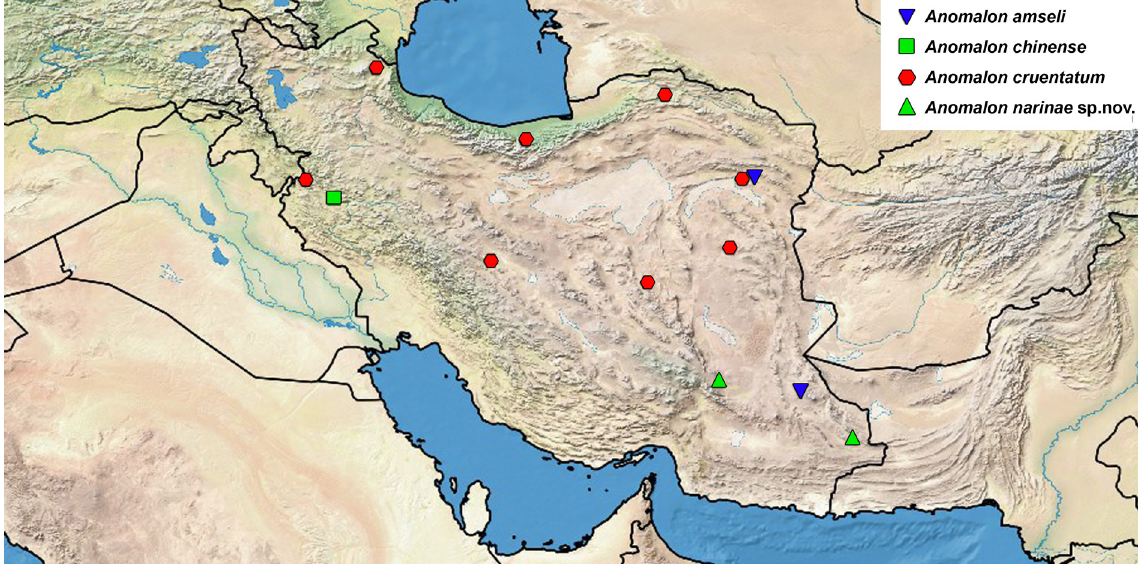
Fig. 1. Distribution map of the known species of Anomalon Panzer, 1804 in